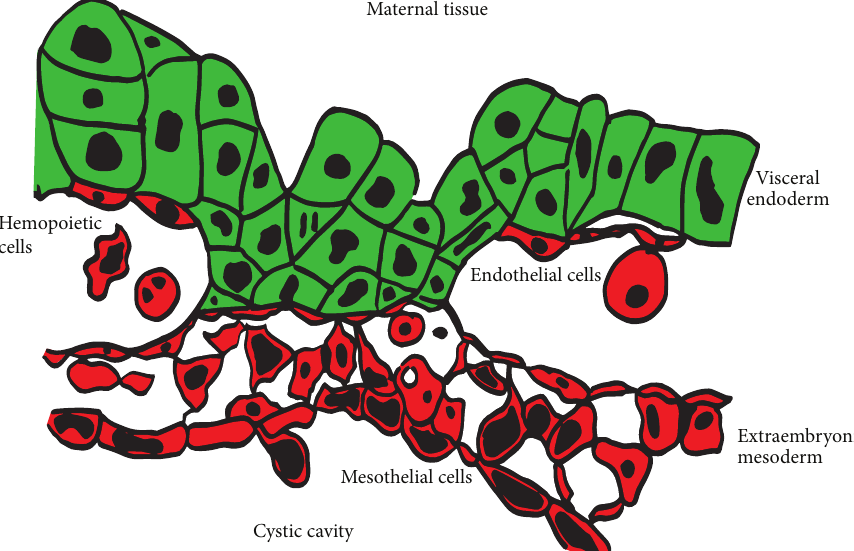
Figure 2: Histology of the yolk sac. The visceral endodermal cells form an epithelial sheet facing the maternal tissue (green). The mesoderm- derived tissue (red) includes vascular endothelial cells, haematopoietic cells, and a thin mesothelial layer facing the embryo